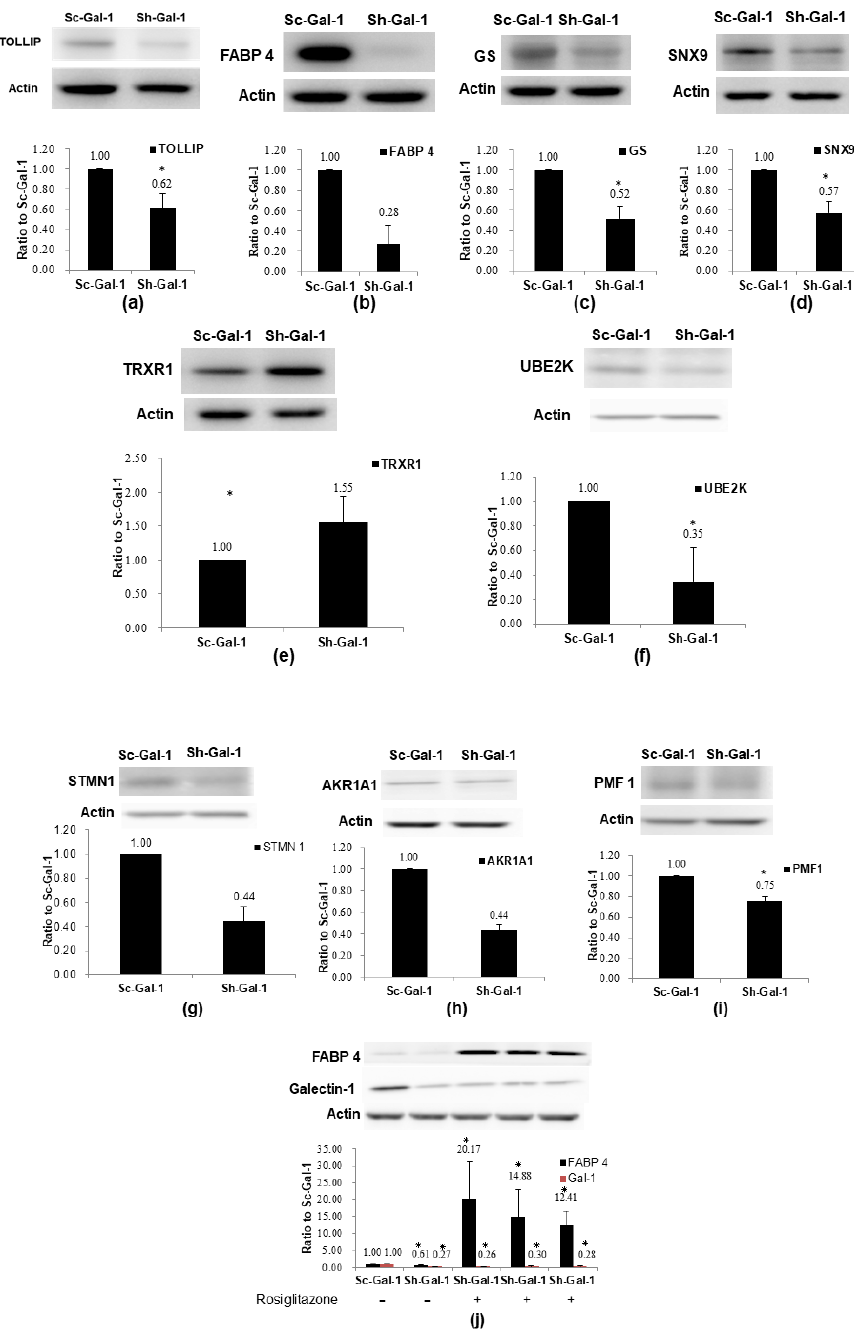
Figure 2. Confirmation of de-regulated proteins evoked by galectin-1 knockdown in T24 cells. ( a ) TOLLIP; ( b ) FABP 4; ( c ) GS; ( d ) SNX9; ( e ) TRXR1; ( f ) UBE2K; ( g ) STMN1; ( h ) AKR1A1; ( i ) PMF1; ( j ) Effects of rosiglitazone (PPAR- γ agonist) on the FABP 4 expression. Western immunoblotting was carried out as described in Materials and Methods. The blot was the representative result of three independent experiments. The protein expression fold (mean ± S.D.) was expressed as the ratio of normalized intensity of the protein of interest (observed protein/actin) in Sh-Gal-1(+120) T24 cells to that in Sc-Gal-1(+120) T24 cells. * p < 0.05.